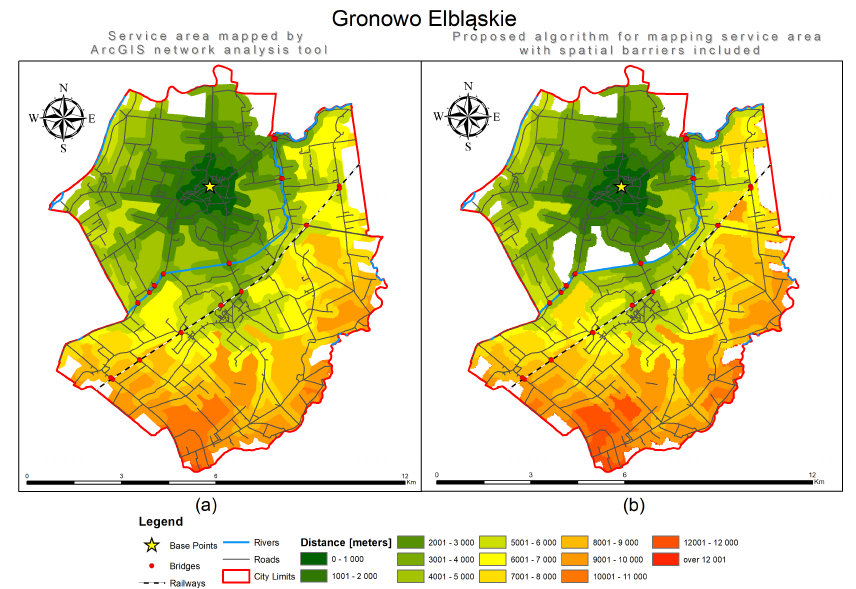
Figure 10. Service areas identified in the city of Gronowo Elbl ˛askie: ( a ) results generated by the standard network analysis tool in ArcGIS; ( b ) results generated by the algorithm developed in the ModelBuilder application in